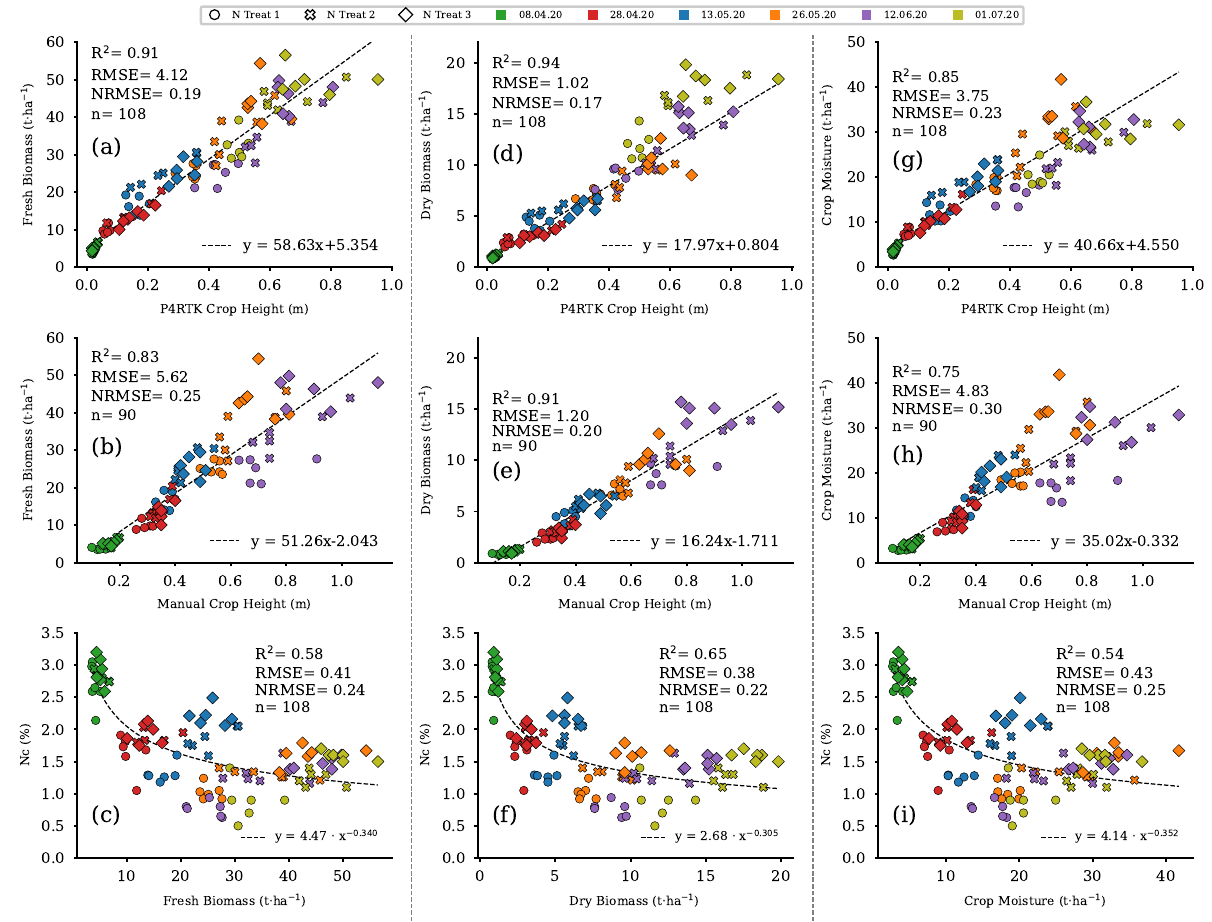
Figure 13. Scatter plots of the linear regression models for P4RTK and manual CH against the fresh and dry biomass as well as crop moisture data of the 18 destructive sampling plots for the five and six sampling dates, respectively. Each column contains a non-linear regression model for estimating N C from the three different biomass parameters. Left column: regression models for fresh biomass ( a – c ). Center column: regression models for dry biomass ( d – f ). Right column: regression models for crop moisture ( g – i ). ( p < 0.001 for all regression